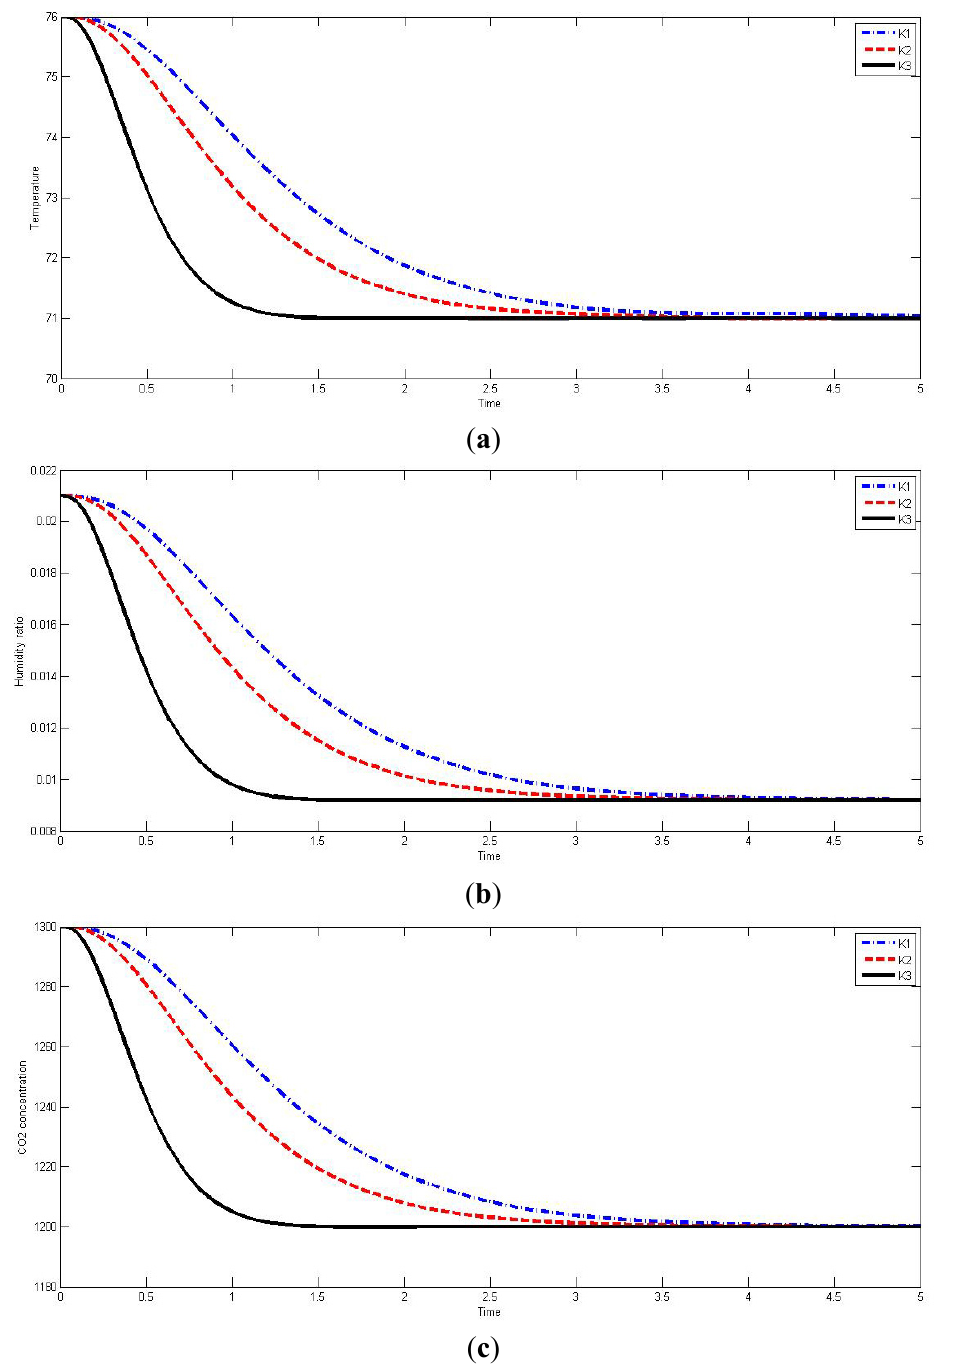
Figure 4. ( a ) Temperature response for each pole placement; ( b ) Humidity ratio response for each pole placement; ( c ) CO concentration response for each pole 2